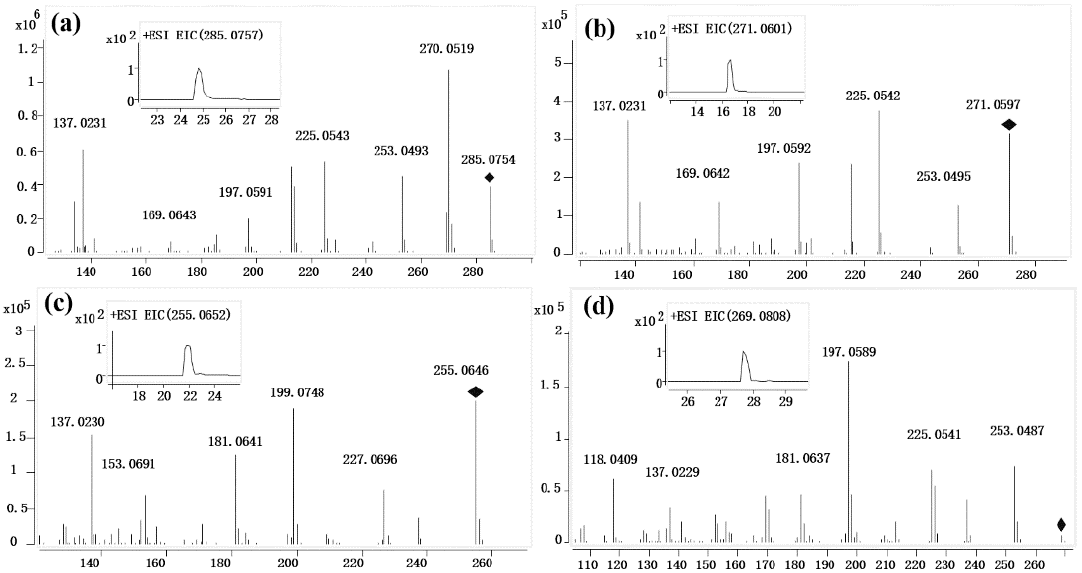
Figure 2. EICs and representative MS/MS spectra of calycosin ( a ), 7,3 ′ ,4 ′ -trihydroxyisoflavon ( b ), daidzein ( c ), and formononetin ( d ).